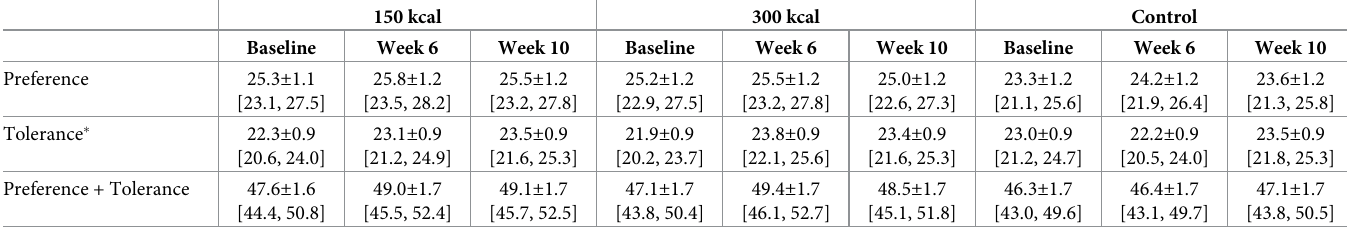
Table 2. Preference and tolerance of exercise intensity discomfort at baseline (week 0), post intervention (week-6) and 4 (week 10) of study participants enrolled in an exercise intervention expending either 150 or 300 kcal per exercise session, 3 days per week for 6-weeks, or in a non-exercise control group.